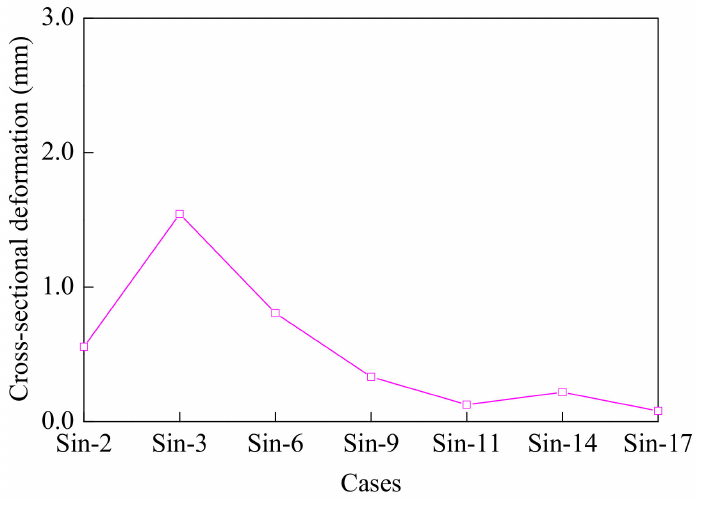
Figure 25. Maximum cross-sectional deformations under different cases.